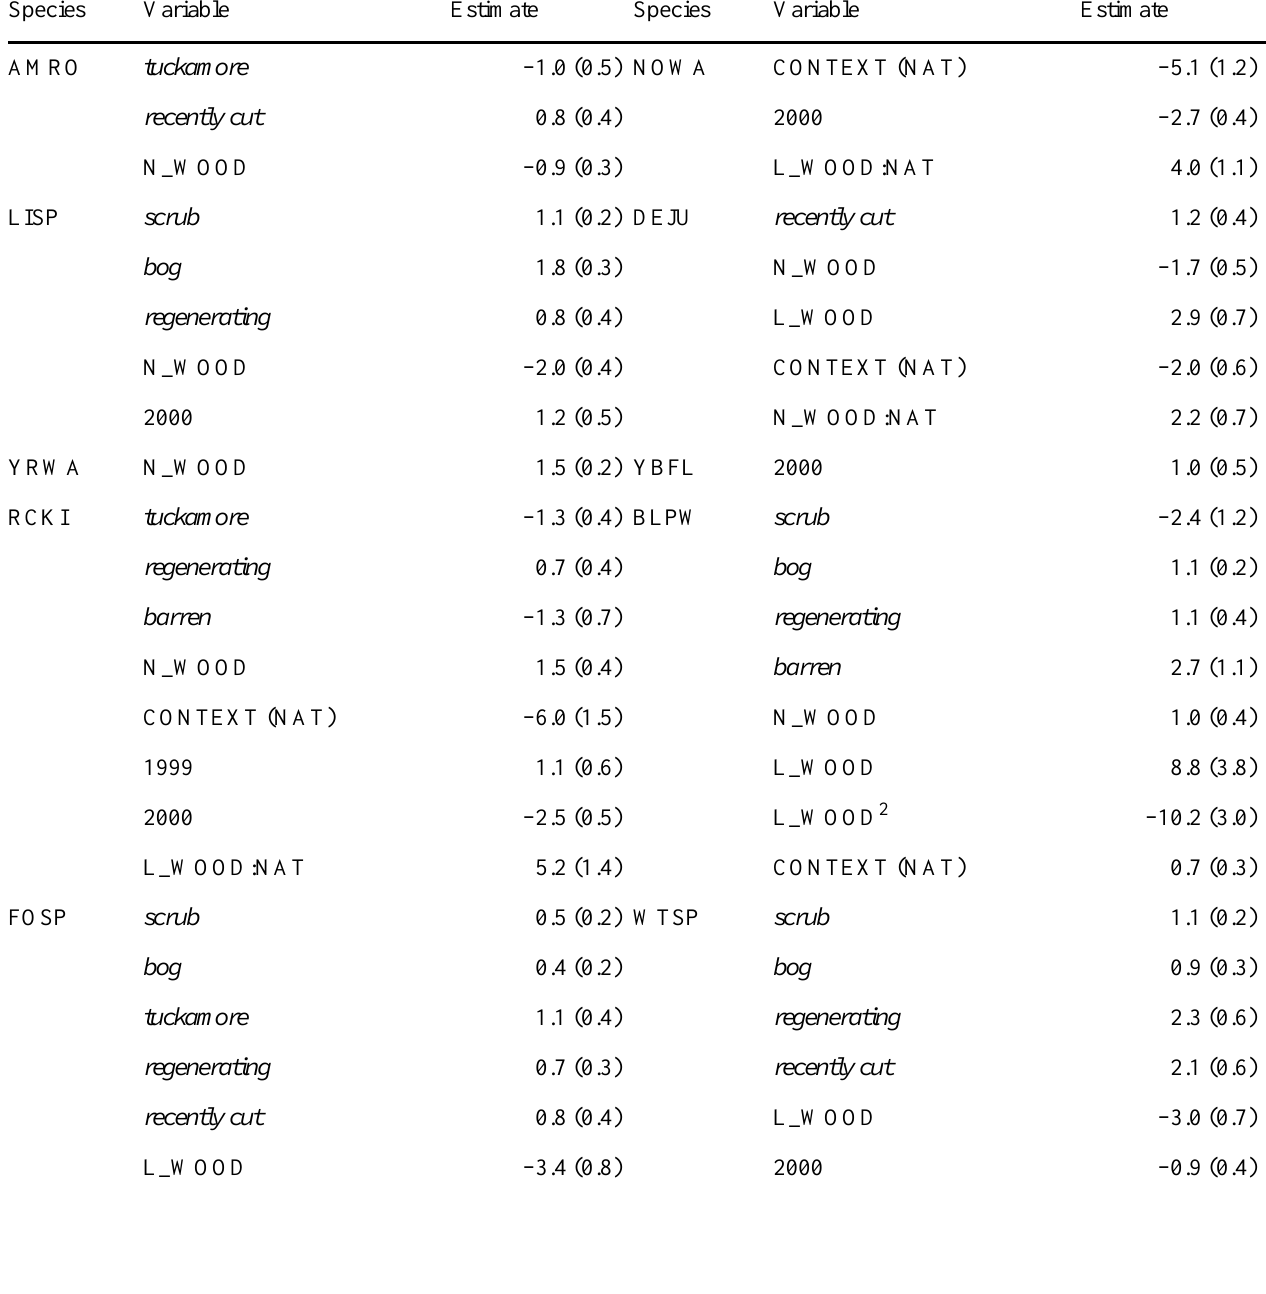
Table 3. Parameter estimates (standard errors in parentheses) for significant variables for the best models (Table 2) to explain the occurrence of focal bird species in western Newfoundland, 1998–2000. Variables in italics are treatment levels of the LOCAL term in relation to forest. For factor terms, for brevity, only levels where the P -value was £ 0.05 are